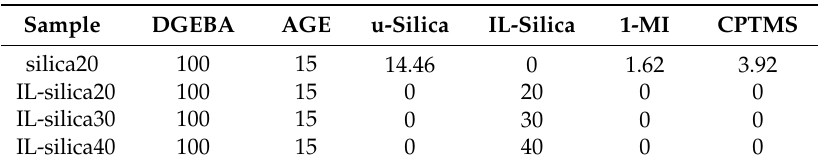
Table 1. The formulation of epoxy composites. DGEBA: diglycidyl ether of bisphenol A; IL-silica: ionic liquid silica; u-silica: un-functionalized